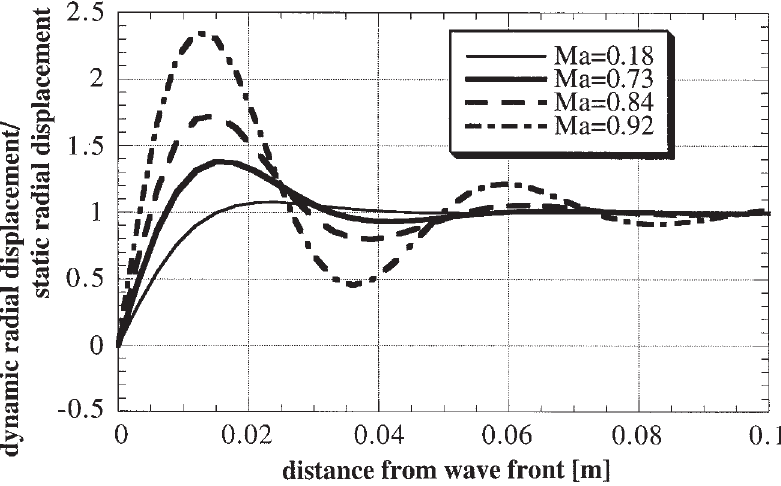
Fig. 16. Wave forms for different propagation speeds of the detonation front, calculated for the tube with inner radius R i = 15 mm and outer radius R a = 24 mm.